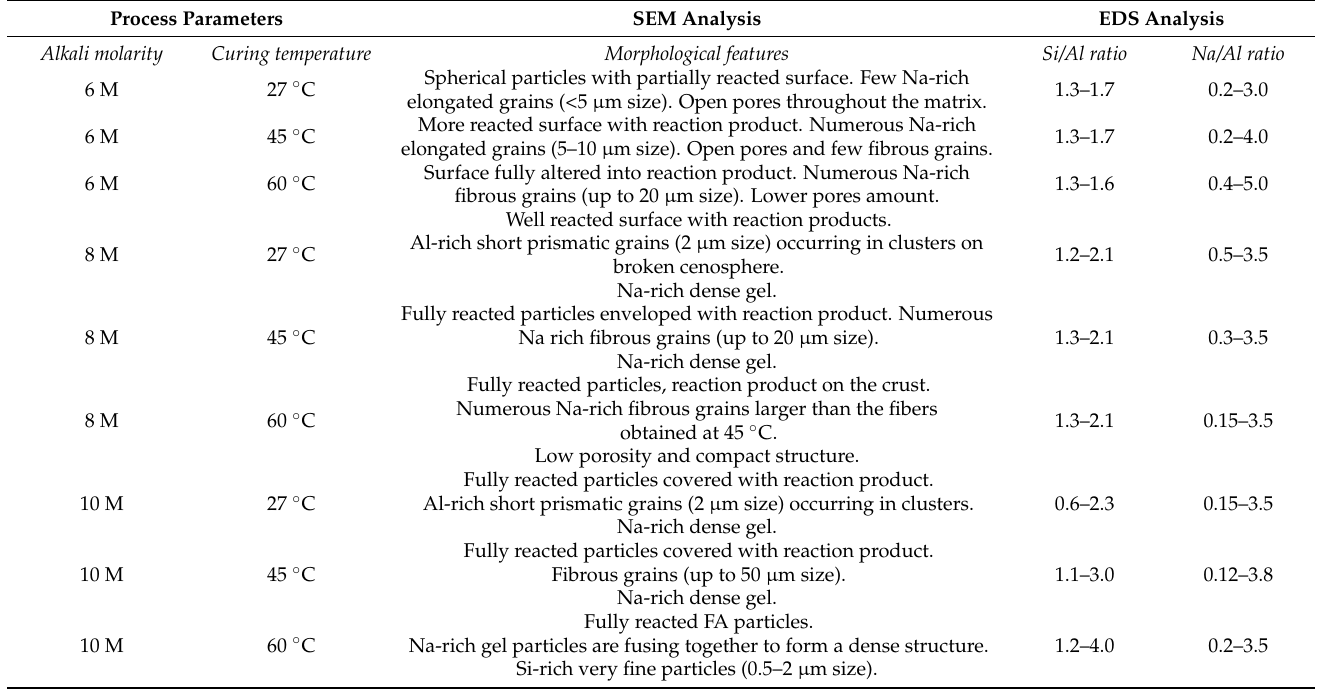
Table 3. SEM Morphology and EDX analysis of FA-based geopolymer microstructures in relation to alkali concentration and curing temperature. Reprinted with permission from Ref. [50]. Copyright 2016